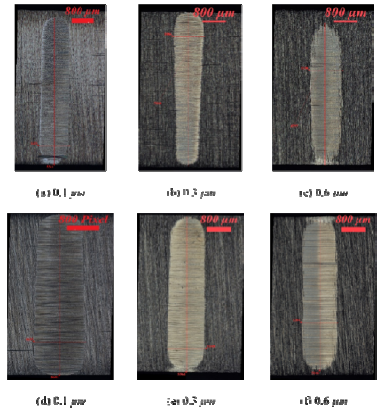
Figure 9. Optical micrographs of wear scar after running-in process for different surface roughness for applied load of 60 N (a, b, c) and 80 N (d, e,